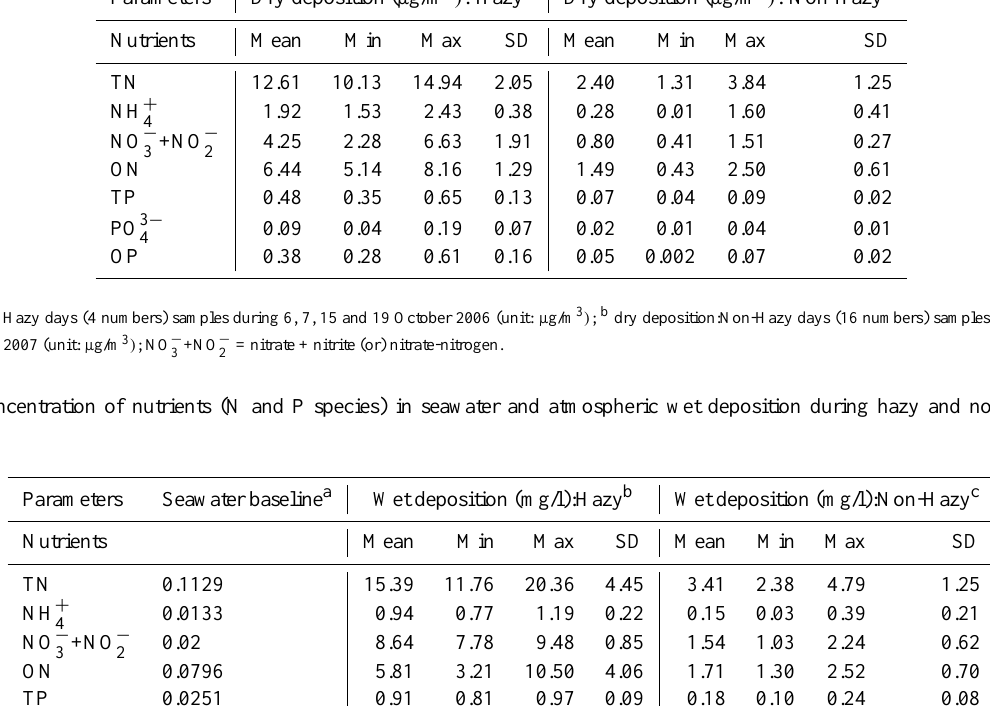
Table 1. Concentration of nutrients (N and P species) in atmospheric dry deposition during hazy and non-hazy days in Singapore. Parameters